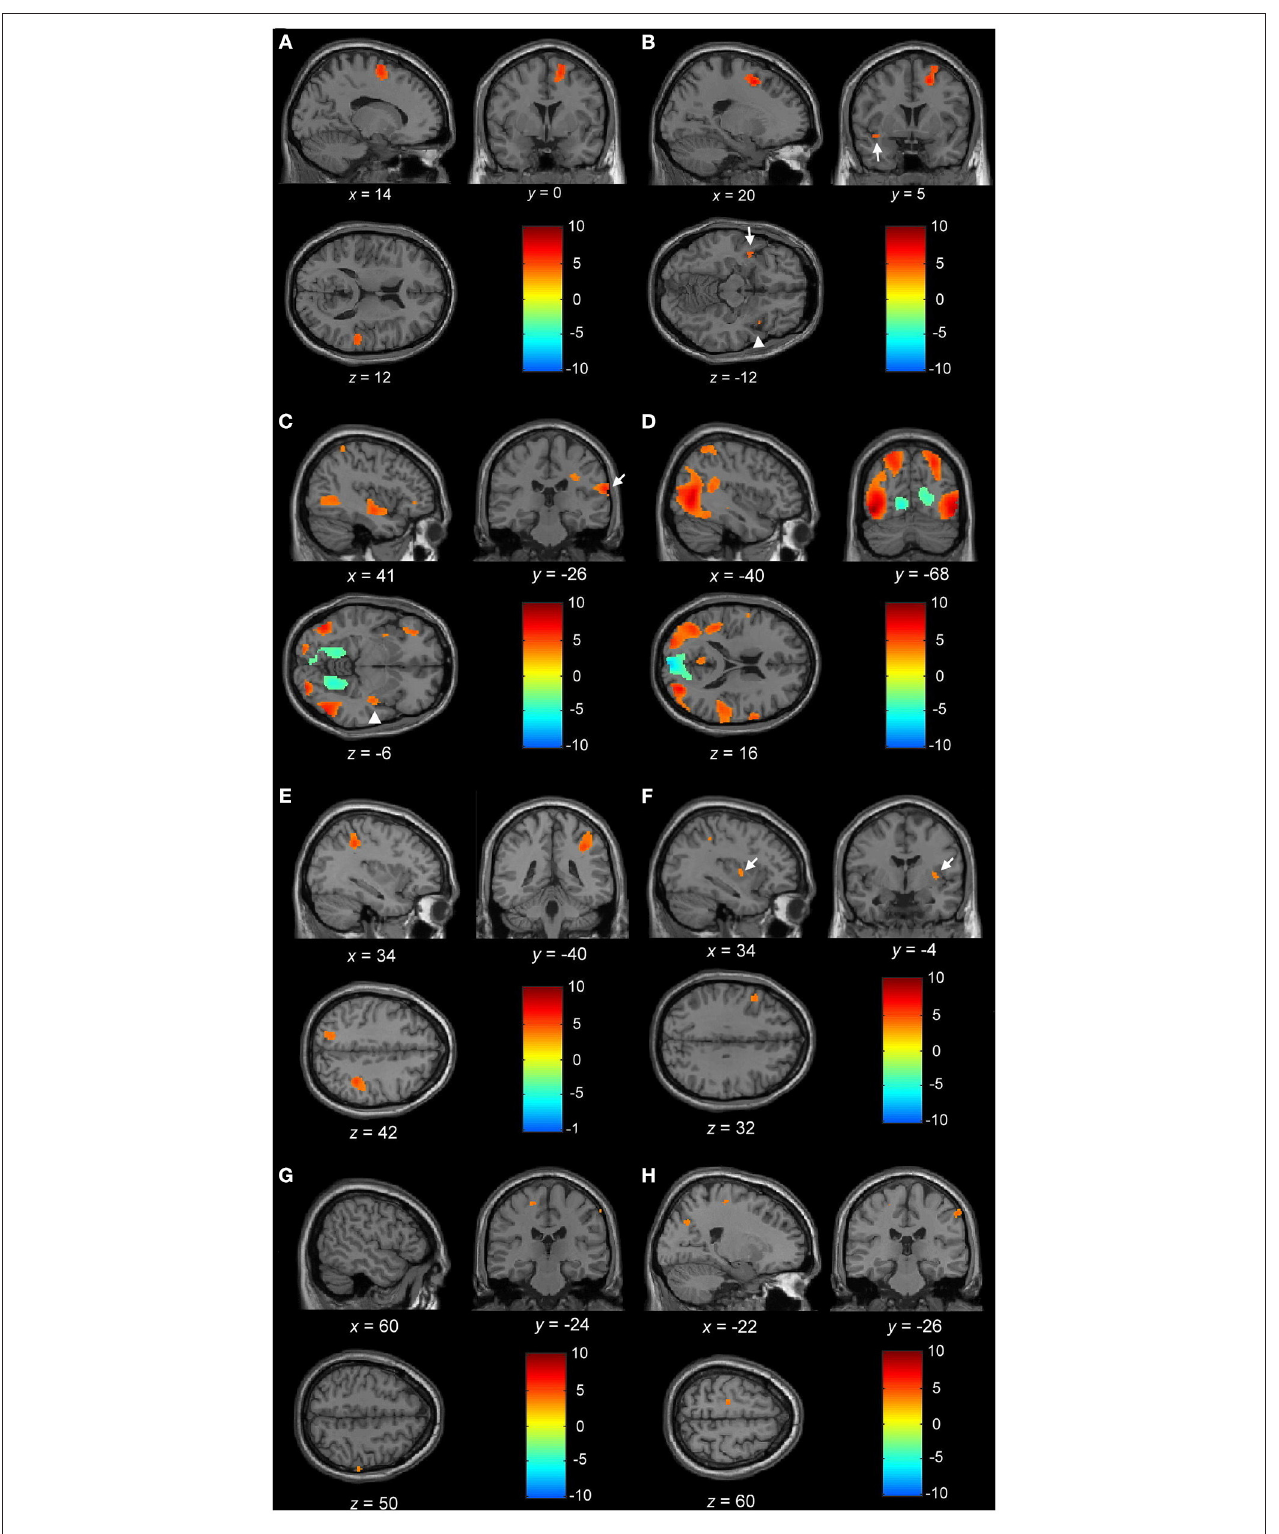
FIGURE 3 | (A) Blood oxygen level-dependent (BOLD) activation during motor imagery (MI) of normal gait with the contrast of normal controls to PD NOFOG . Increased BOLD in the right SMA, right superior temporal gyrus, left SMA (not shown), and right medial superior frontal gyrus (not shown). (B) BOLD activation during MI of FOG gait with the contrast of PD FOG to PD NOFOG . Increased BOLD in the right superior and middle frontal gyrus, right insula (arrowhead), left superior temporal cortex (arrow), and left superior frontal gyrus (not shown). (C) BOLD activation during MI of FOG straight walking in PD FOG . Increased BOLD in the right insula